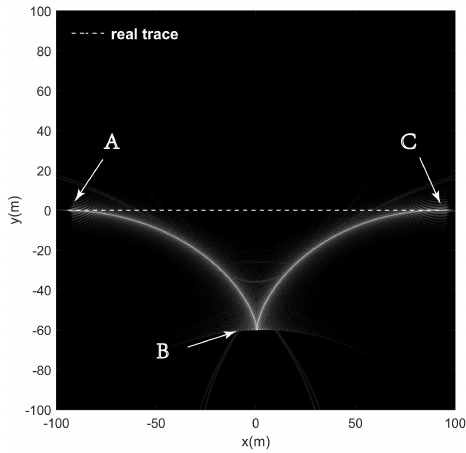
Figure 7. Target’s real trace and moving target SAR image. The target moved at 4 m/s along the dashed line from left to